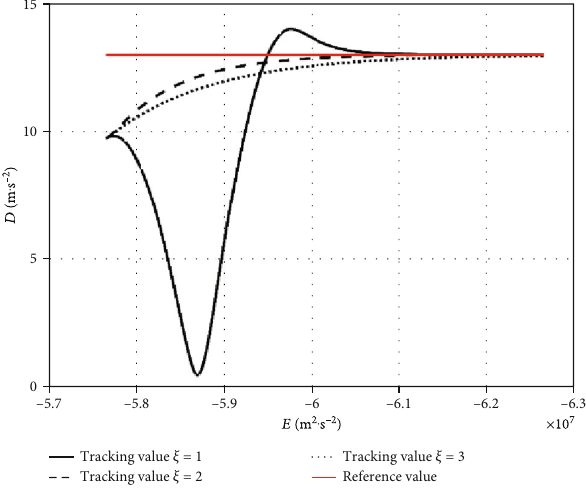
Figure 3: Drag acceleration command tracking process with ξ = 2 . = n